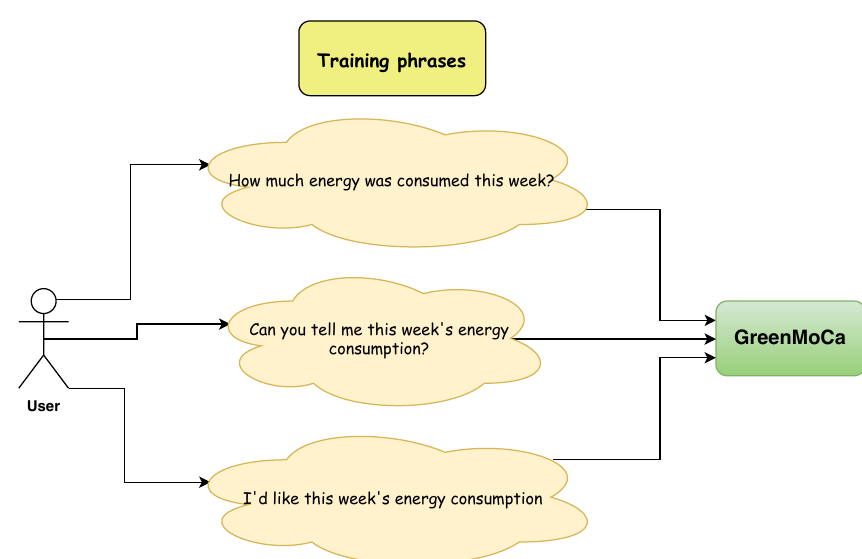
Figure 3. Example of training phrases to ask GreenMoCA for the energy consumption of the current week. These phrases have been translated from the original ones (in Spanish).